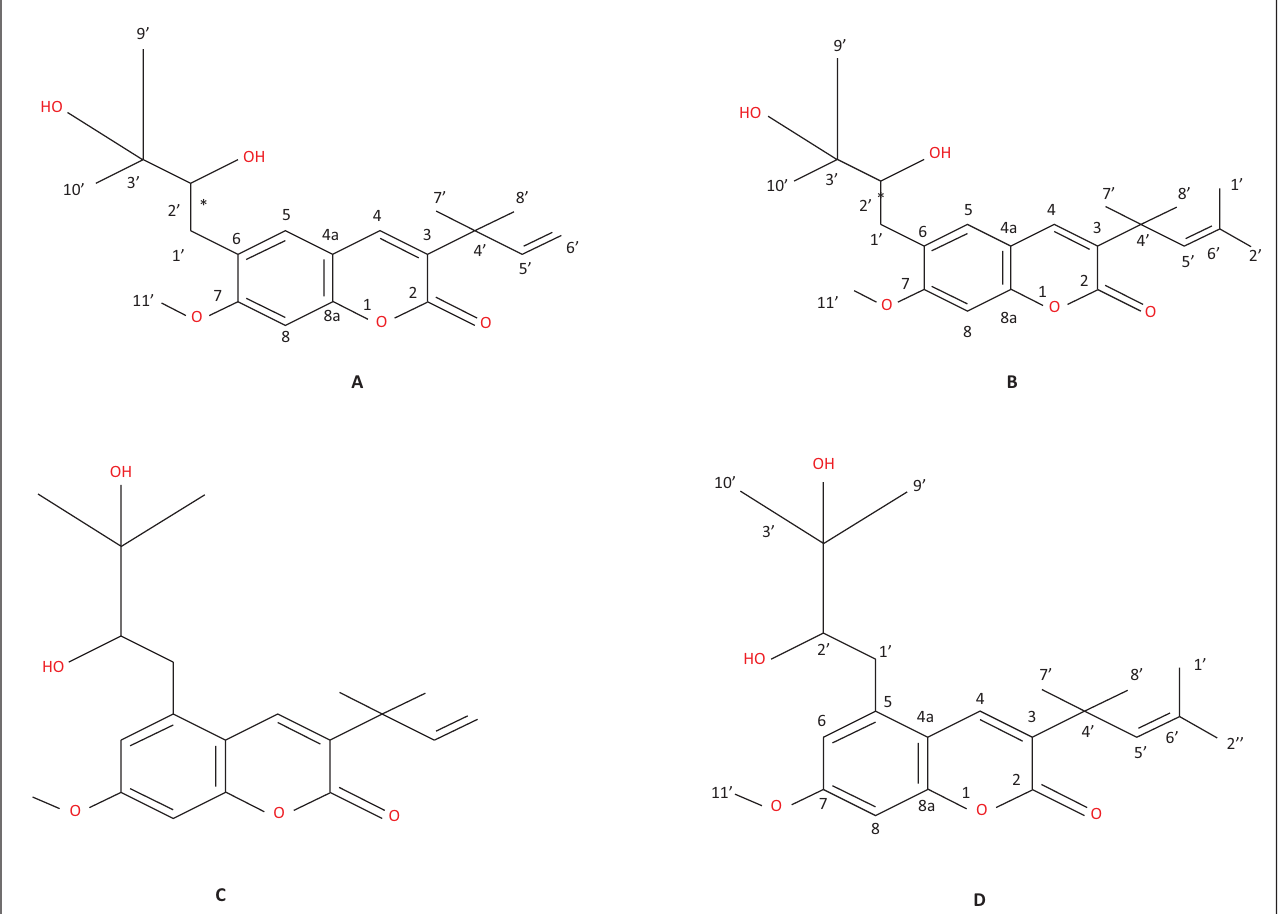
FIGURE 5: Compounds isolated from Fraction A of acetone extract of C. anisata : (A-C) coumarin derivatives, (D) (S/R)-3-(1,1,3-trimethyl- 2-butenyl)-5-(2,3-dihydroxy-3- methylbutane)-7-methyl-2H-1-benzopyran-2-one.